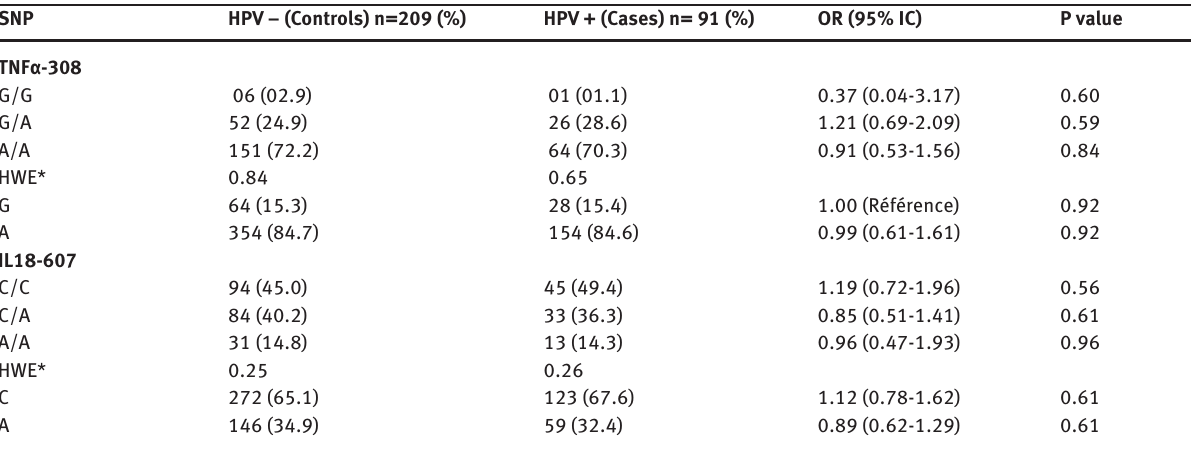
Table 2: Allele and genotype frequencies TNFA -308 (rs1800629) and IL18 -607 C/A (rs1946518) polymorphisms among women infected with HPV and negative HPV controls.